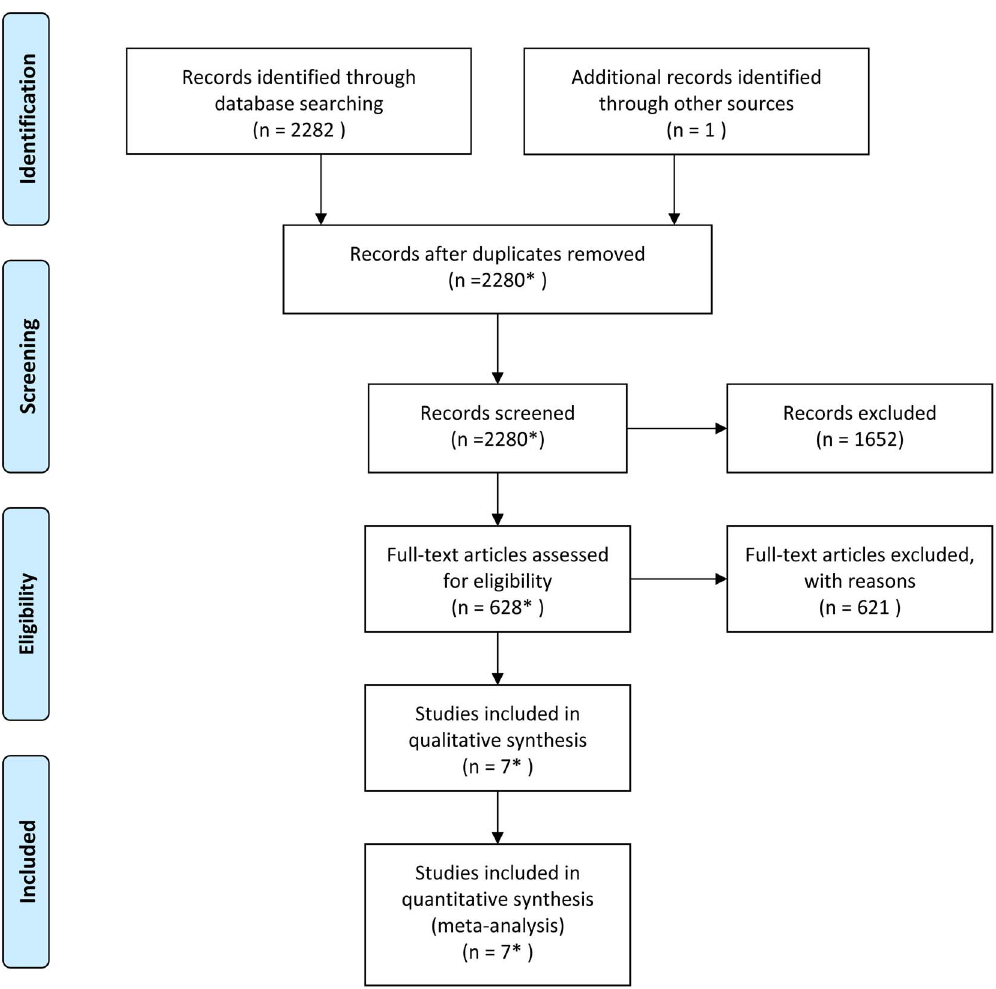
Figure 1. Flow diagram of literature search. *Includes one commentary providing updated efficacy (but no toxicity) results of one of the included randomized trial.